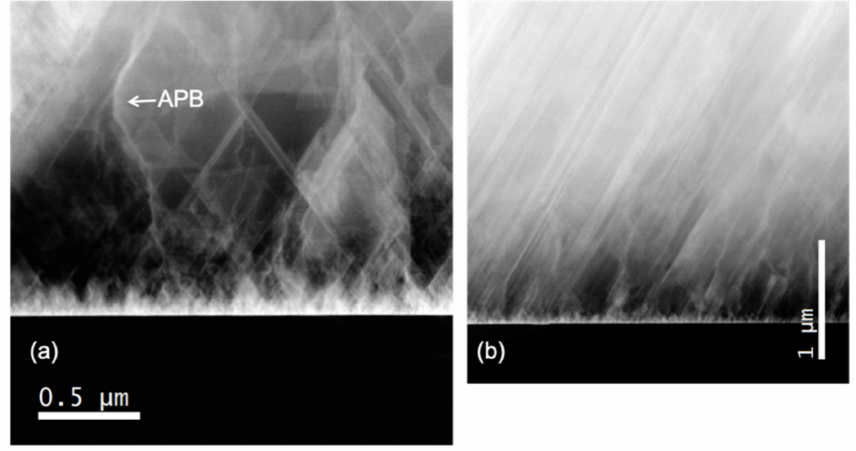
Figure 2. ( a ) TEM cross-section of a 3C-SiC layer grown on on-axis silicon. APBs and SFs in opposite directions are visible. ( b ) TEM cross-section of a 3C-SiC layer grown on off-axis silicon. No APBs can be observed while only SFs in the step direction are